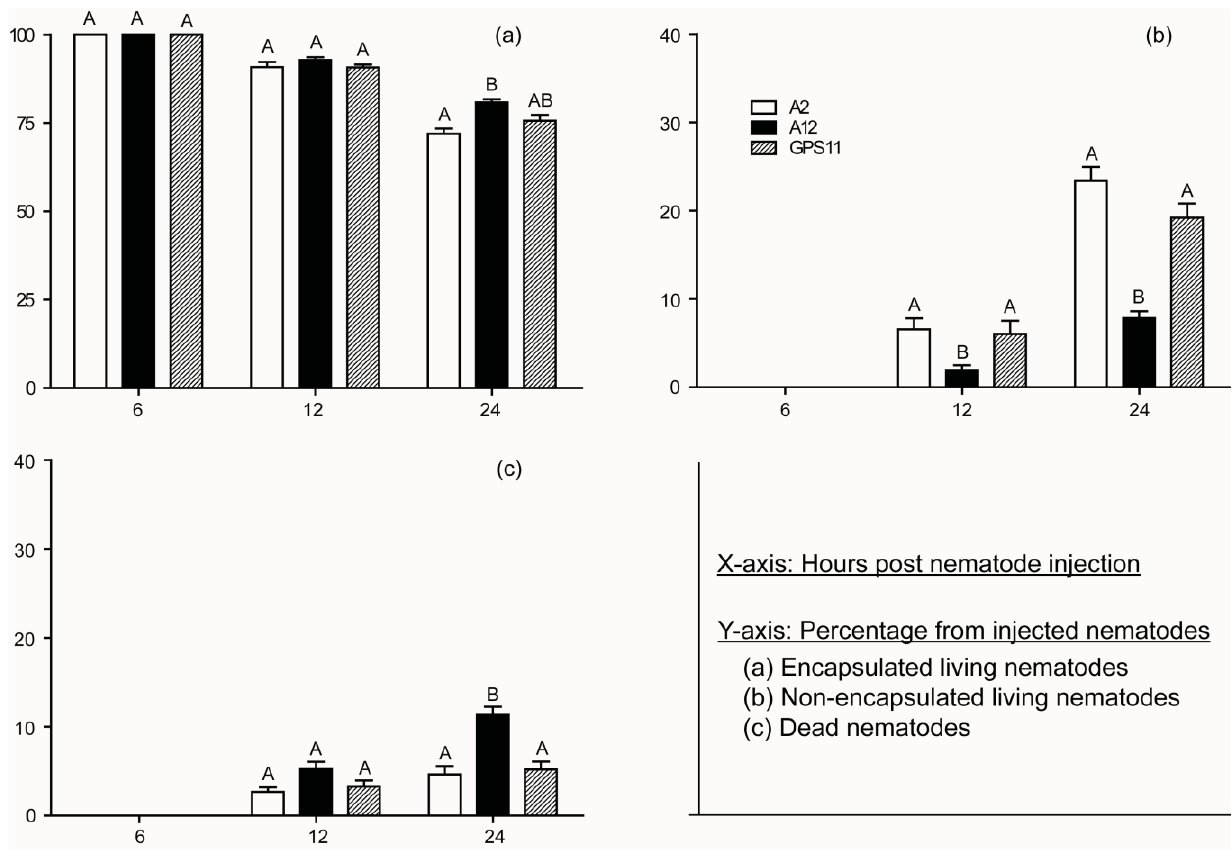
Figure 3. Percentages of encapsulated living, non-encapsulated living, and dead Heterorhabditis bacteriophora nematodes in Popillia japonica grubs at 6, 12 and 24 h post hemocoel-injection with infective juvenile nematodes of line A2, line A12 and GPS11 strain. The percentages (mean ± SEM) of encapsulated living, non-encapsulated living and dead nematodes were compared separately at each time interval. The same letter indicates no statistical difference at P = 0.05 (Tukey’s HSD